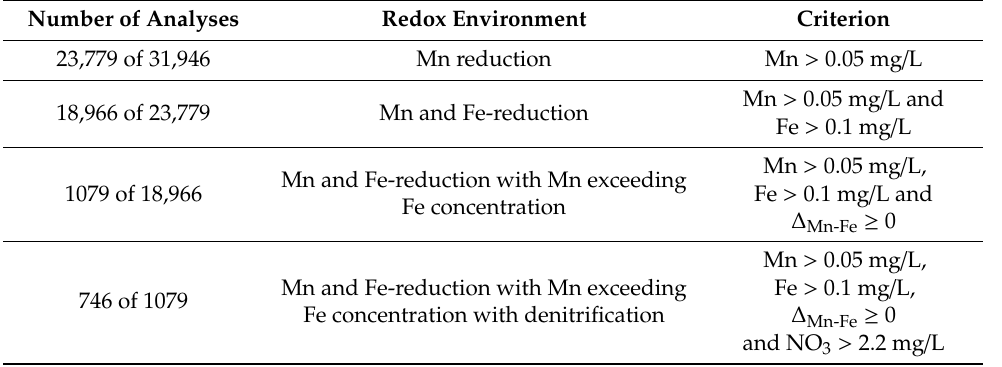
Table 4. Number of analyses in showing denitrification, Mn-, and Fe- reduction, partly simultaneously. Number of Analyses Redox Environment